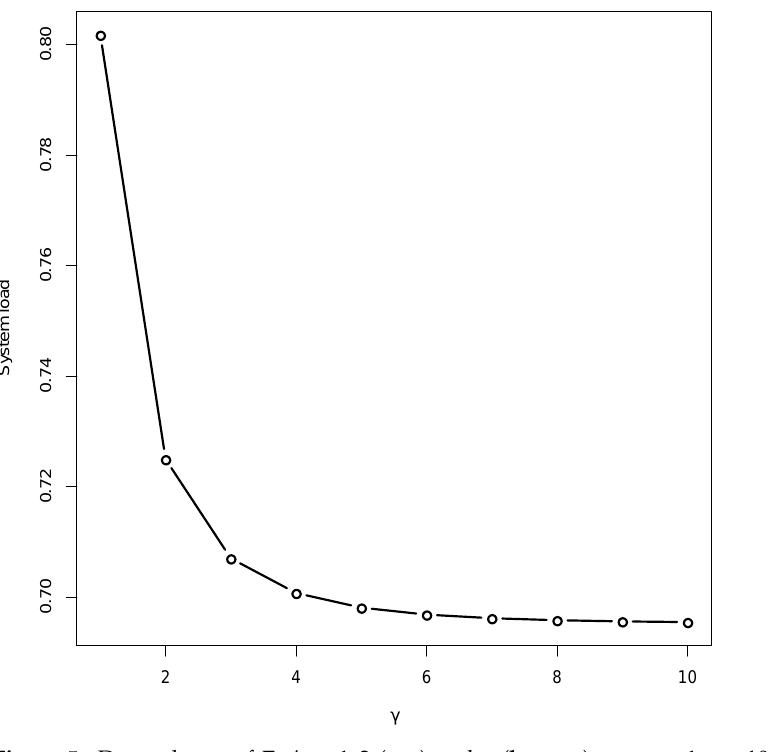
Figure 5. Dependency of E i , i = 1,2 ( top ) and ρ ( bottom ) on γ = 1, . . . ,10 for S = 50, s = 5, l 2 = 10, µ 1 = 7, µ 2 = 15, MMAP arrival process parameters given in (49). Figure 6 (top) describes the dependency of the mean inventory level ¯I defined in (39), while, in Figure 6 (bottom), the replenishment rate ¯R is depicted, for γ = 1, . . . , 10. As ex- pected, with increasing γ the inventory contents increases, along with the replenishment rate.